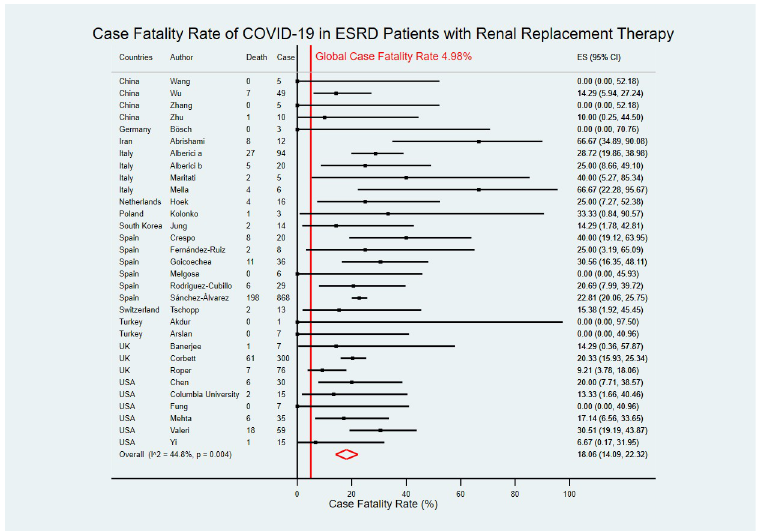
Fig 6. Forest plot of the case fatality rate of COVID-19 in ESRD patients with RRT. The figure summarizes the number of COVID-19 deaths in ESRD patients with RRT and the number of COVID-19 confirmed cases in ESRD patients with RRT in 31 eligible studies. The forest plot represents the estimated case fatality rate of COVID-19 in ESRD patients with RRT for each study (black boxes), with 95% confidence intervals (95% CI; horizontal black lines). The estimated pooled case fatality rate (red diamond) was 18.06% (95% CI 14.09–22.32). The global case fatality rate (vertical red line) was 4.98%. The meta-analysis used a random-effects model with the exact method for confidence interval estimation. ES, effect size. I 2 , test for heterogeneity.